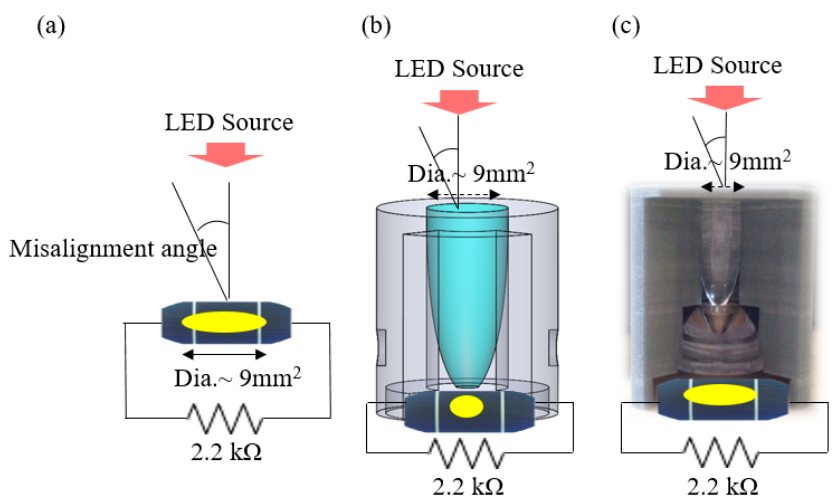
Figure 28. The experimental set-up: ( a ) the naked photovoltaic (PV) panel; ( b ) the CPC; ( c ) the CPC with the collimator.